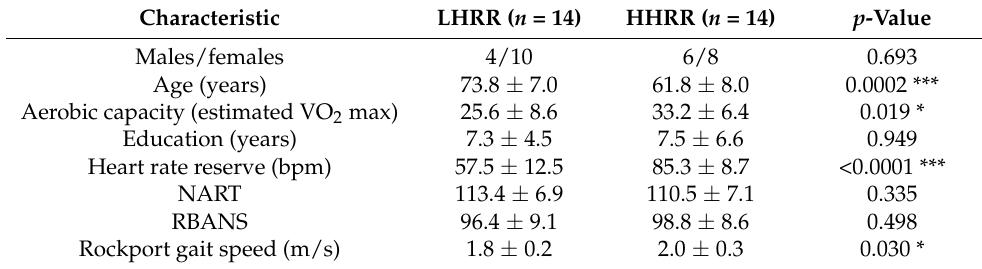
Table 1. Participant